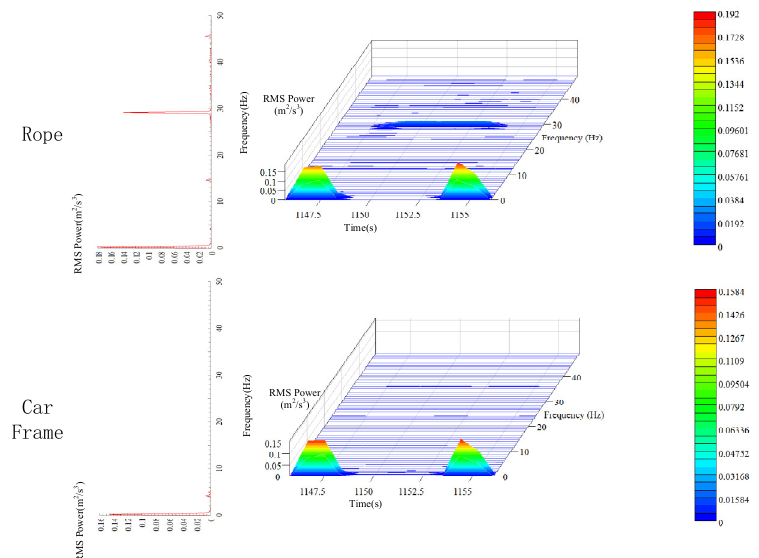
Figure 14. Time-frequency characteristics of the hoist rope and car frame.